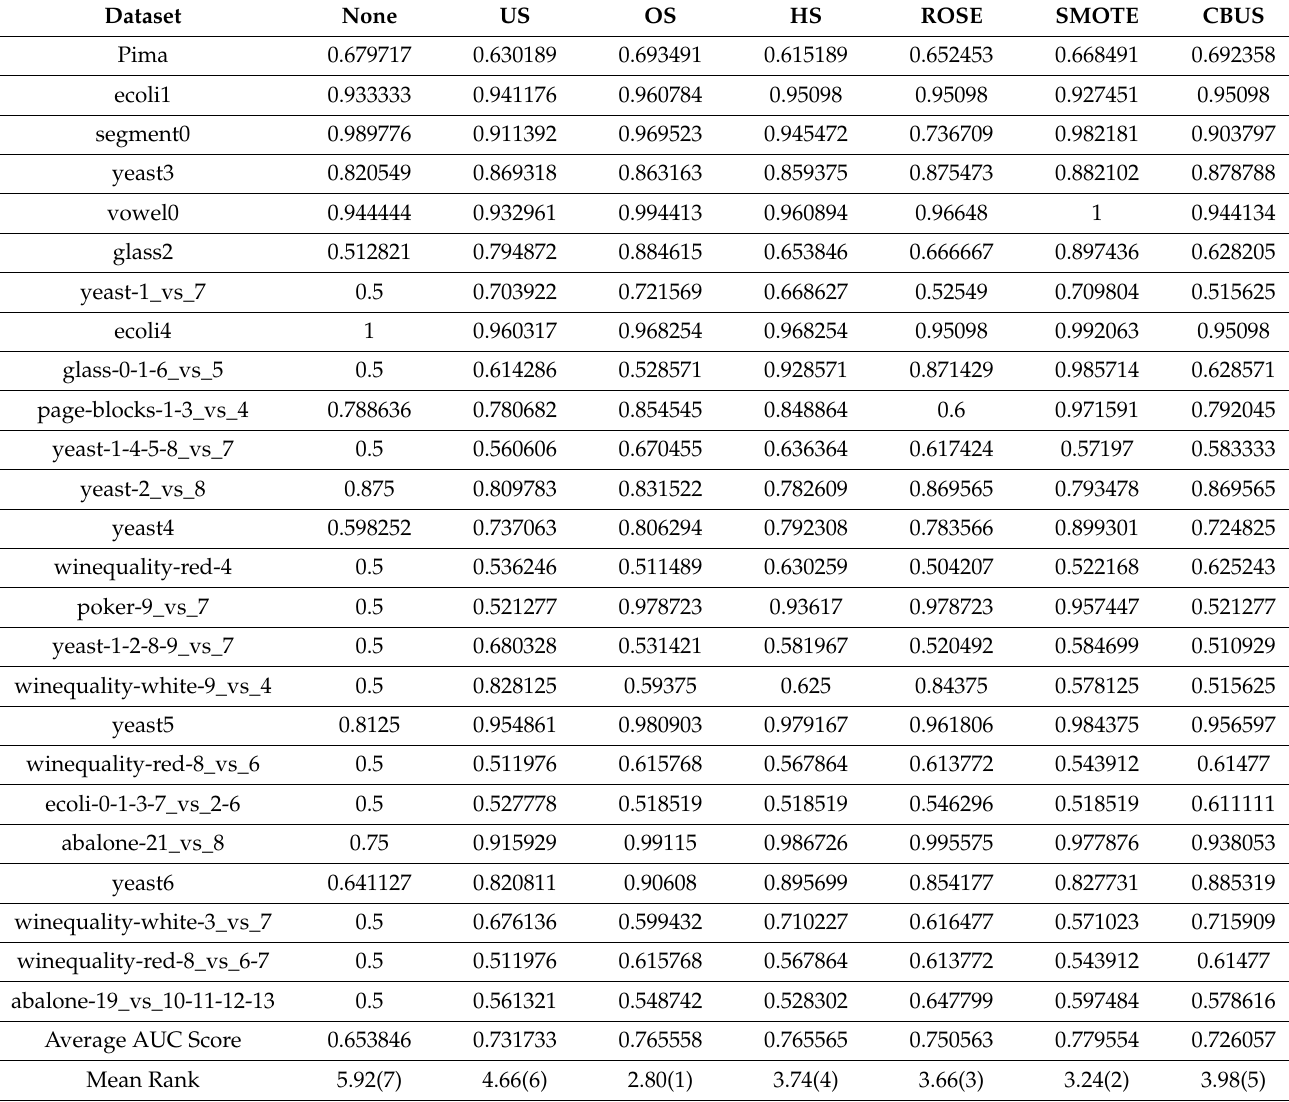
Table 3. Performance of DBT for kNN classifier.